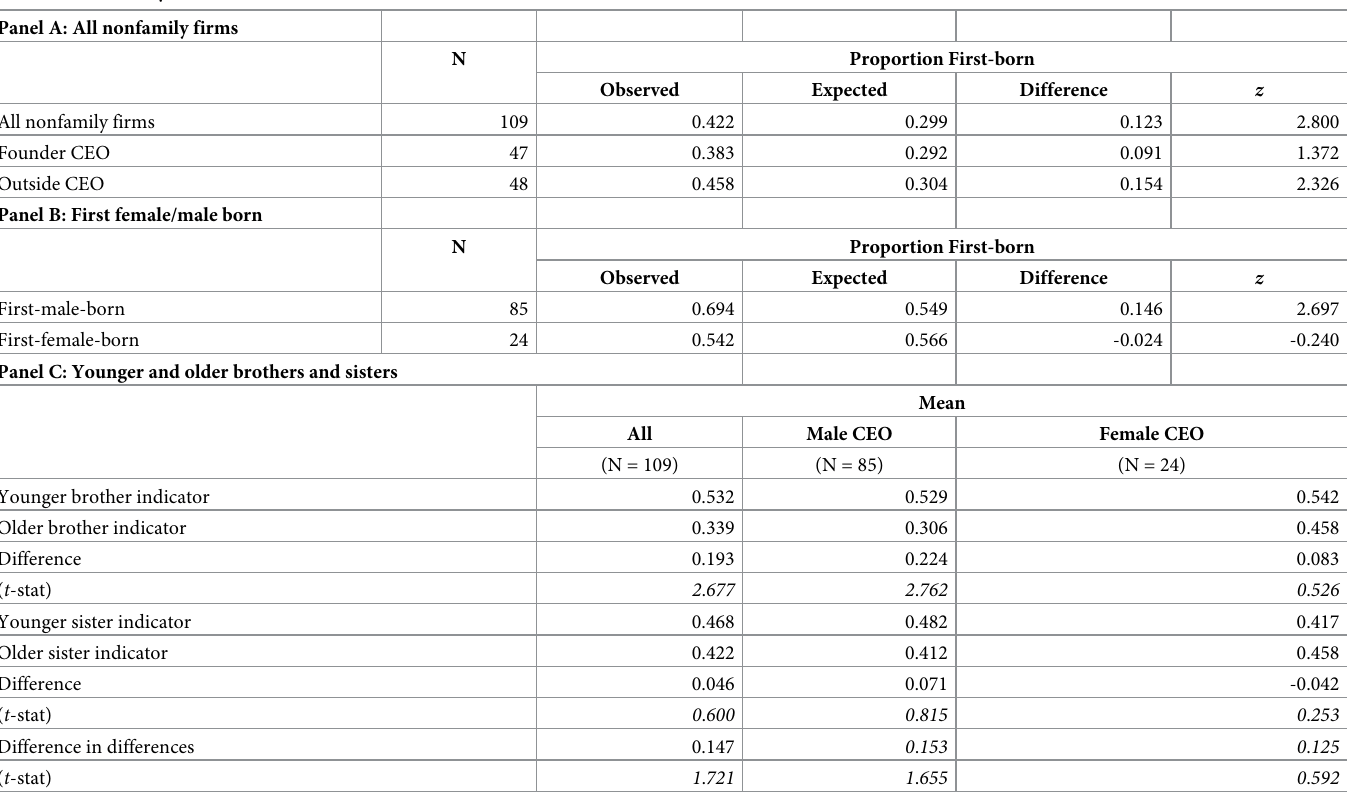
Table 5. Non-family